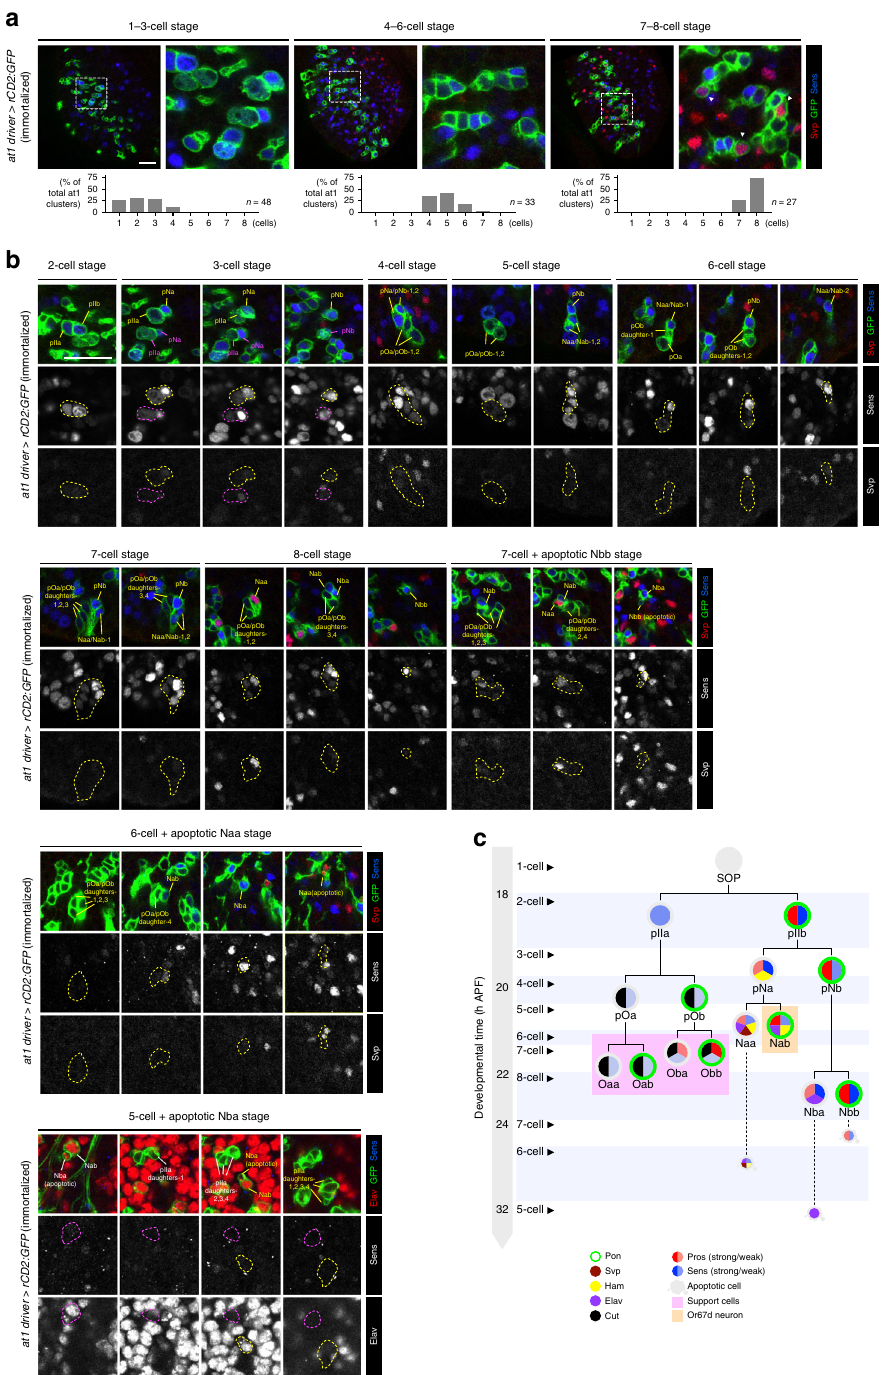
Fig. 5 The at1 lineage is synchronized in cell division sequence and marker expression. a Full views of the immortalized at1 driver-labeled lineages (using an rCD2:GFP reporter; green) on pupal antennae at three developmental time points. For each time point, all the at1 lineages have comparable numbers of daughter cells and identical Svp (red) and Sens (blue) expression patterns (shown in the magni fi ed views of the boxed regions). The histograms show the percentage of at1 lineages at different cell stages. Scale bar = 20 µ m in this and other panels. b Close-up views of the SOP and its daughter cells in the at1 lineage (green) reveal a highly stereotyped series of cell divisions from 2 to 8 cells, before the Nbb, Naa and Nba cells undergo sequential apoptosis. Most of the intermediate and terminal daughter cells in this lineage could be unambiguously identi fi ed based on the expression of Svp (red) and Sens (blue), as well as their position within the cluster (division typically occurs along the same axis). For the last apoptotic Nba stage, Elav (red) marks the neural-speci fi c Nab and Nba cells. Where necessary, multiple focal planes are shown to visualize all the cells in each cluster. The yellow or magenta dashed lines within each cell stage outline the same at1 cluster at different focal planes (across multiple panels). c Schematic showing the division time, birth sequence and expression pattern of molecular markers in the at1 lineage (based also upon data from Supplementary Fig. 3c – e)